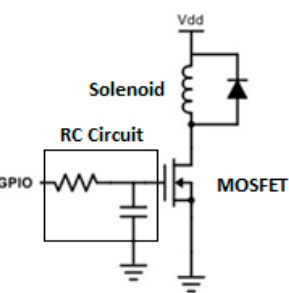
Figure 4. Schematic of the control circuit used to drive the direct current through the solenoid. V dd represents the 14.8 V power source while the coil directly below V dd represents the electromagnet used to lift the topmost ball.